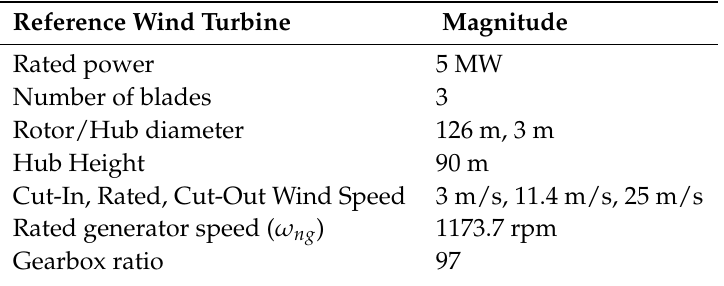
Table 1. Gross properties of the wind turbine.